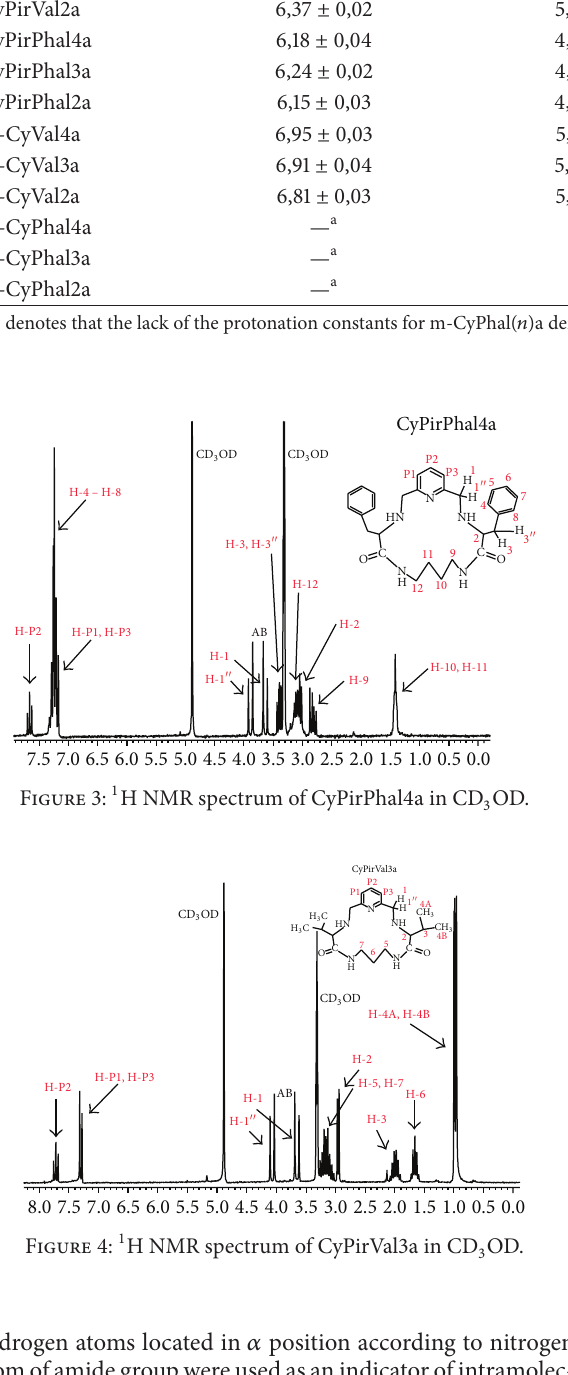
hydrogen atoms located in 𝛼 position according to nitrogen atom of amide group were used as an indicator of intramolec- ular hydrogen bond. Signals of those protons are split in 1 H NMR spectrum of CyPirPhal( 𝑛 )a ligands (protons: H-9 and H-12 in CyPirPhal4a, Figure 3). This can lead to